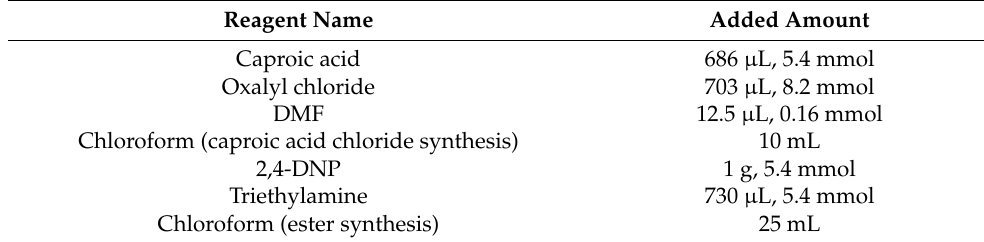
Table 1. Reagents ratio for 2,4-DNP-C6 (compound 3 ) synthesis. Reagent Name Added Amount Caproic acid 686 µ L, 5.4 mmol Oxalyl chloride 703 µ L, 8.2 mmol DMF 12.5 µ L, 0.16 mmol Chloroform (caproic acid chloride synthesis) 10 mL 2,4-DNP 1 g, 5.4 mmol Triethylamine 730 µ L, 5.4 mmol Chloroform (ester synthesis) 25 mL